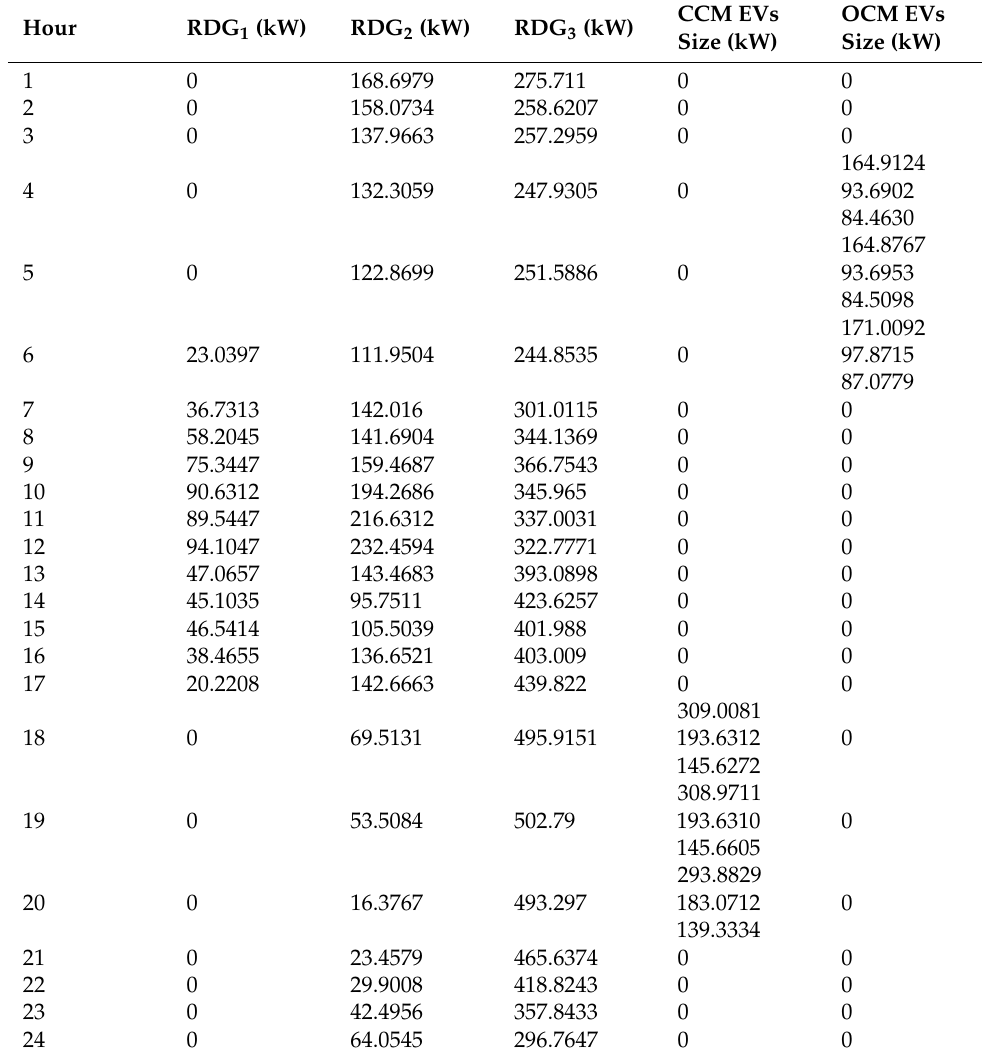
Table 6. RDG and EV scheduling with considering